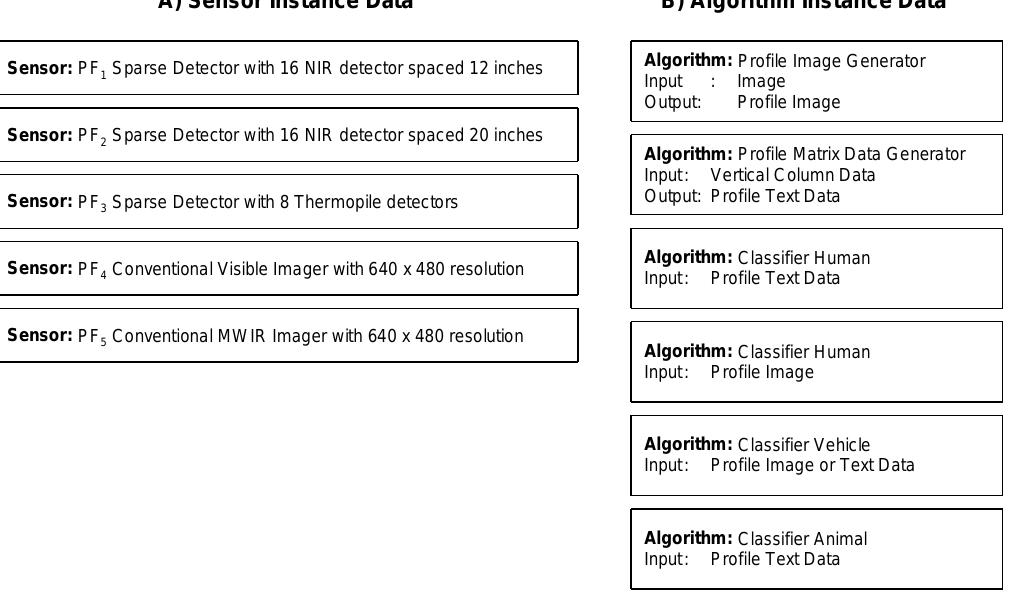
Figure 21. Five new Profiling_Sensor_System instances returned, with derived relationships, after the first pass of the inference